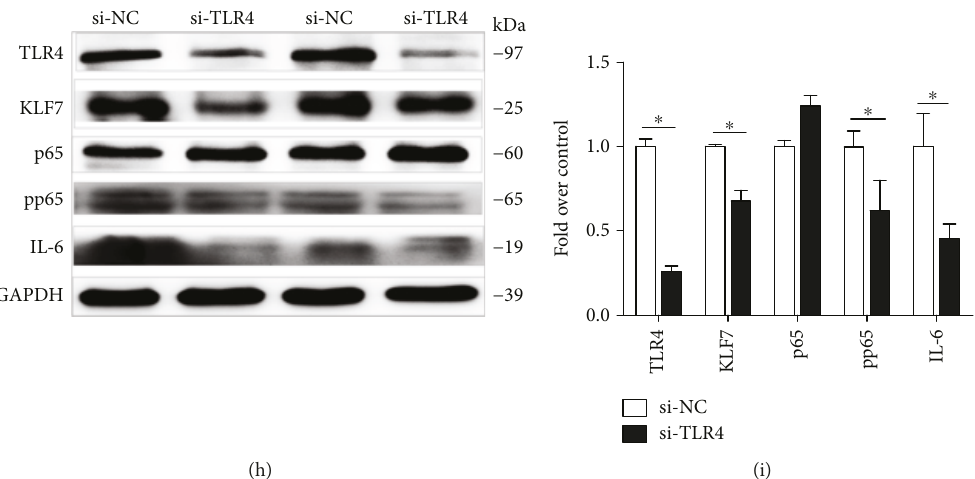
Figure 2: The TLR4 expression level in cells after 24h and 48 h upregulation of the TLR4 overexpression plasmid (a). The mRNA expression of KLF7, p65, and IL-6 in adipocytes was detected after 48h of upregulation of the TLR4 expression (b – d). The protein expression levels of KLF7, pp65, and IL-6 in adipocytes after 48h upregulation of the TLR4 expression (e). The transfection e ffi ciency after 8h transfection with di ff erent concentrations of si-FAM fl uorescent fragments into adipocytes (g). The protein expression levels of KLF7, pp65, and IL-6 in adipocytes after 48 h downregulation of the TLR4 expression (h). Grayscale scanning of proteins from (e) and (h) (f, i) (Ad-TLR4: transfected TLR4 overexpression plasmid, Ad-NC: transfected TLR4 negative control overexpression plasmid, siTLR4: transfected siRNA of TLR4, and siNC: transfected negative control of siRNA). The data for each group is derived from three replicates of experimental data. One-way ANOVA (a – d), T test (f, i), ∗ P < 0 05 , ∗∗ P < 0 01 ; the di ff erence was statistically signi fi